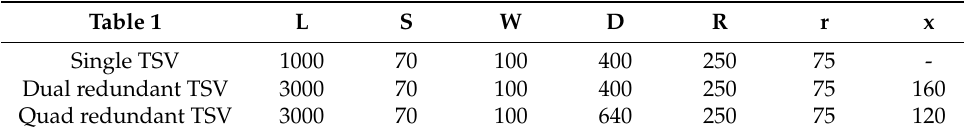
Figure 2. Test structure simulation result.